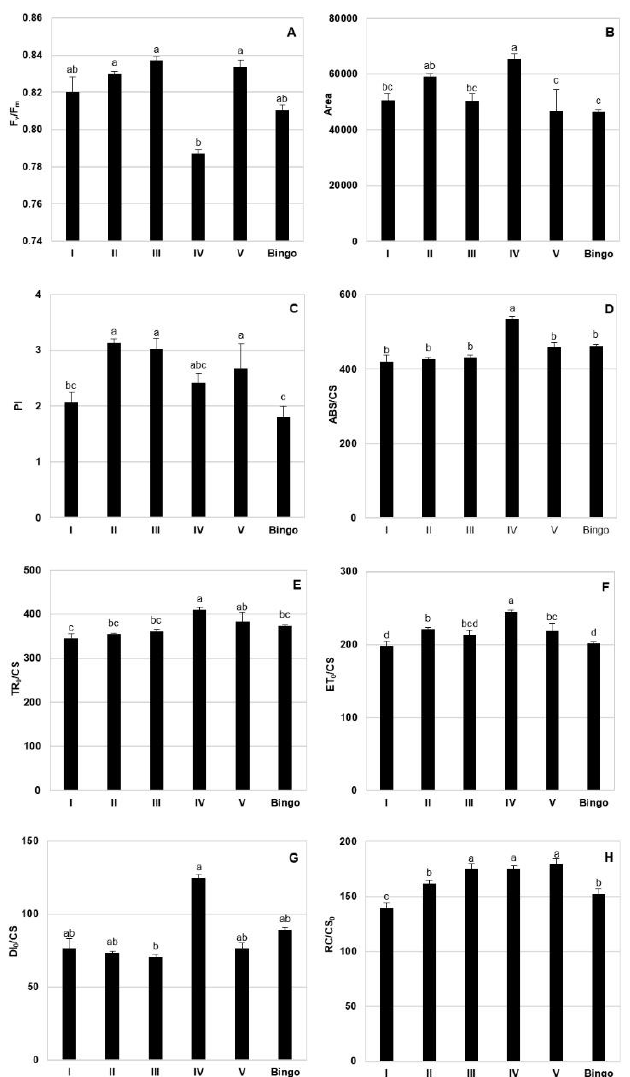
Figure 4. Chlorophyll a fluorescence parameters in the leaves of OMA lines and cv. Bingo in